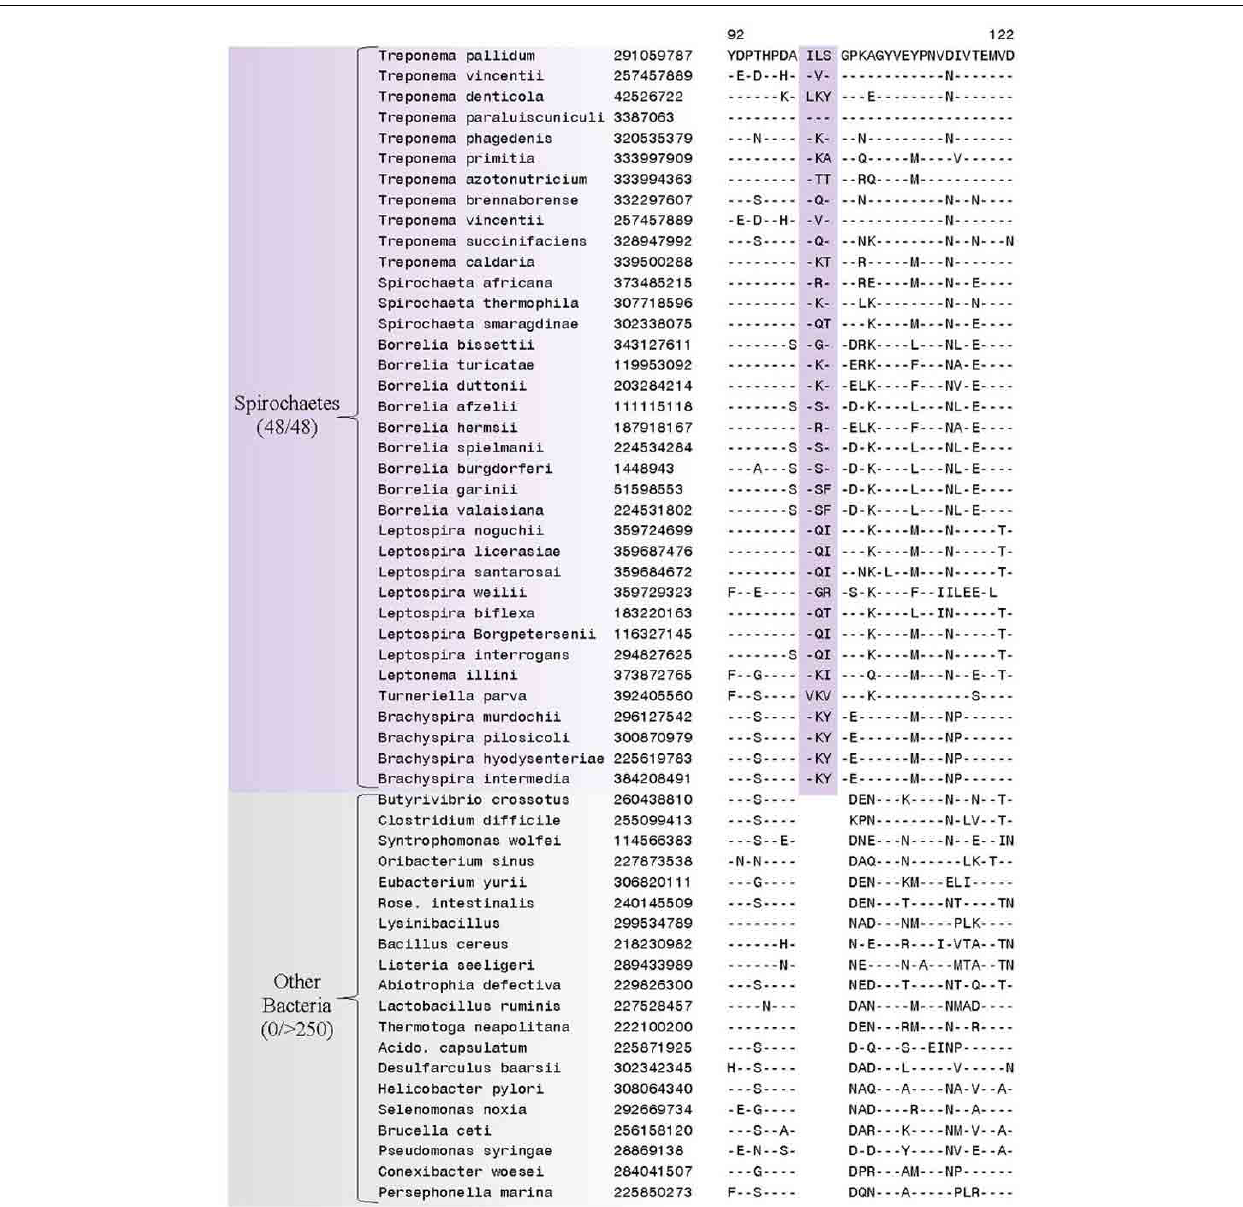
FIGURE 3 | A partial sequence alignment of the flagellar basal-body rod protein FlgC, showing a CSI (boxed) that is uniquely present in all members of the phylum Spirochaetes. Sequence information for only a limited number of species from the Spirochaetes and other bacteria is shown here, but unless otherwise indicated similar CSIs were detected in all members of the indicated